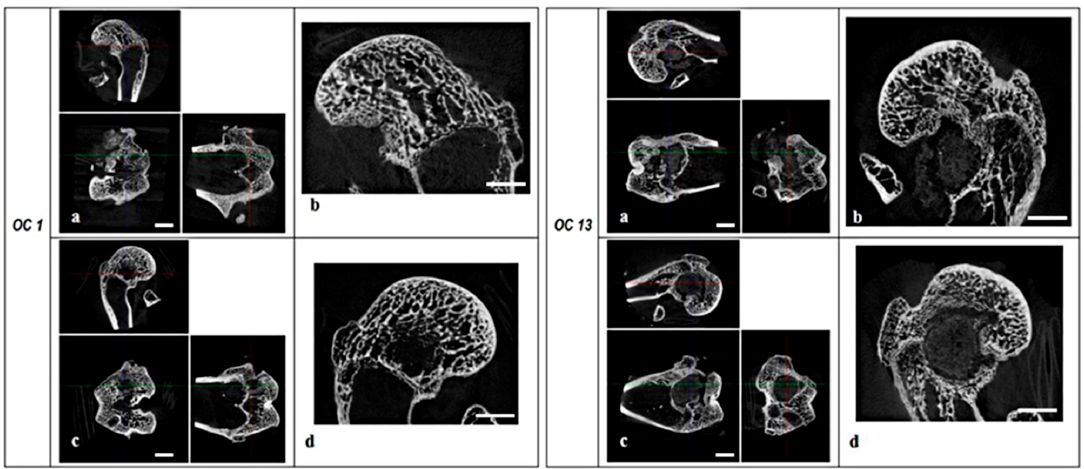
Figure 1. RegenOss ( left panel ) and experimental group ( right panel ) micro-CT sections. Organization of each panel: ( a ) Micro-CT sections of the right leg samples in the axial, sagittal, and coronal planes, scale bar 5 mm; ( b ) Lateral condyle sagittal micro-CT section ( right leg samples ), scale bar 3 mm; ( c ) micro-CT sections of the left leg samples in the axial, sagittal, and coronal planes, scale bar 5 mm; ( d ) lateral condyle sagittal micro-CT section ( left leg samples ), scale bar 3